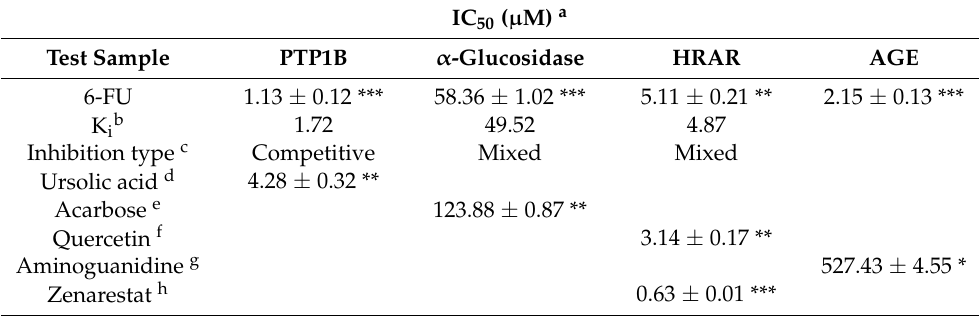
Table 1. Inhibitory effects and enzyme kinetic analysis of 6-FU on protein tyrosine phosphatase 1B (PTP1B), α -glucosidase, human recombinant aldose reductase (HRAR), and advanced glycation end-product